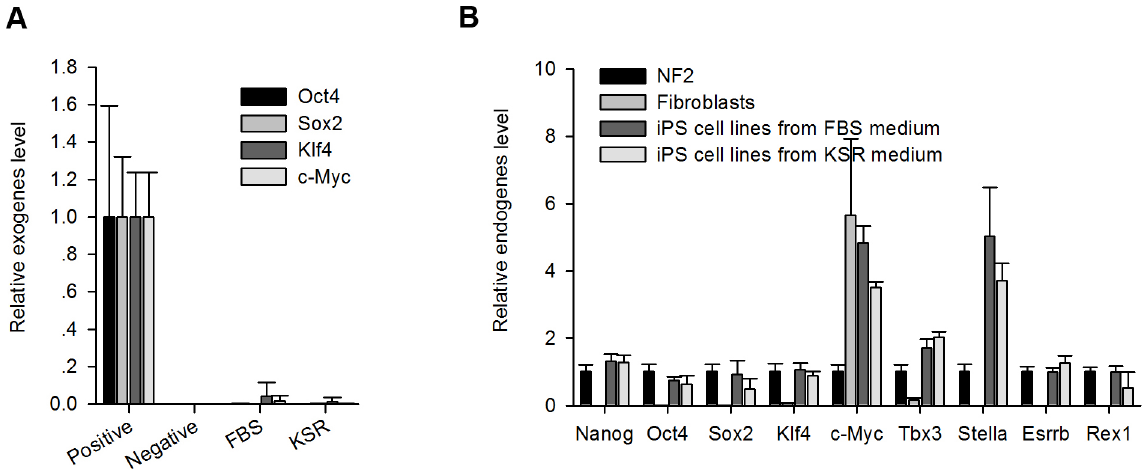
Figure 5. Expression of pluripotency genes of KSR group and FBS group at P12. (A) qPCR analysis of pluripotent exogenes ( Oct4 , Sox2 , Klf4 , c-Myc ) in Positive (fibroblasts transfected by four Yamanaka factors), Negative (fibroblasts), FBS (iPS cell lines induced in the FBS medium at P12), and KSR (iPS cell lines induced in the medium at P12). (B) qPCR analysis of pluripotent endogenes ( Oct4 , Sox2 , Klf4 , c-Myc , Nanog , Tbx3 , Stella , Esrrb , Rex1 ) in Positive (NF2, ES cells), Negative (fibroblasts), FBS (iPS cell lines induced in FBS medium at P12), and KSR (iPS cell lines induced in KSR medium at P12).